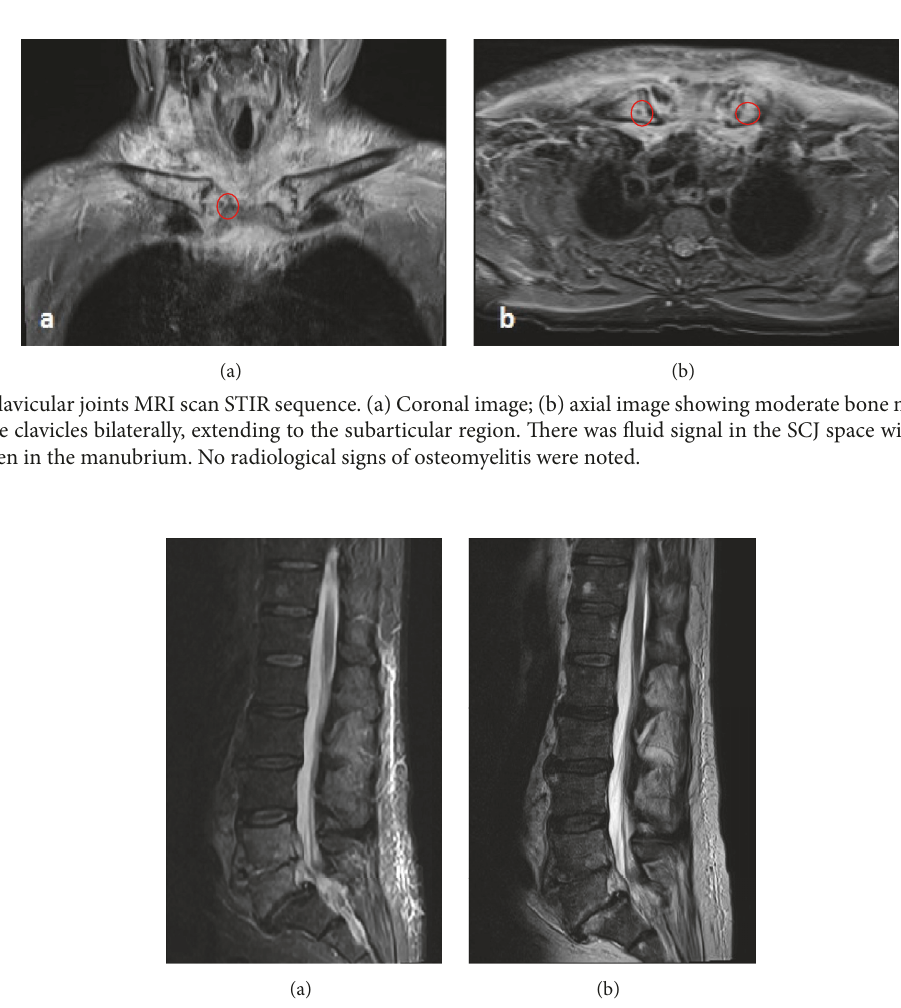
Figure 4: Lumbar spine MRI scan. (a) STIR sequence; (b) T2